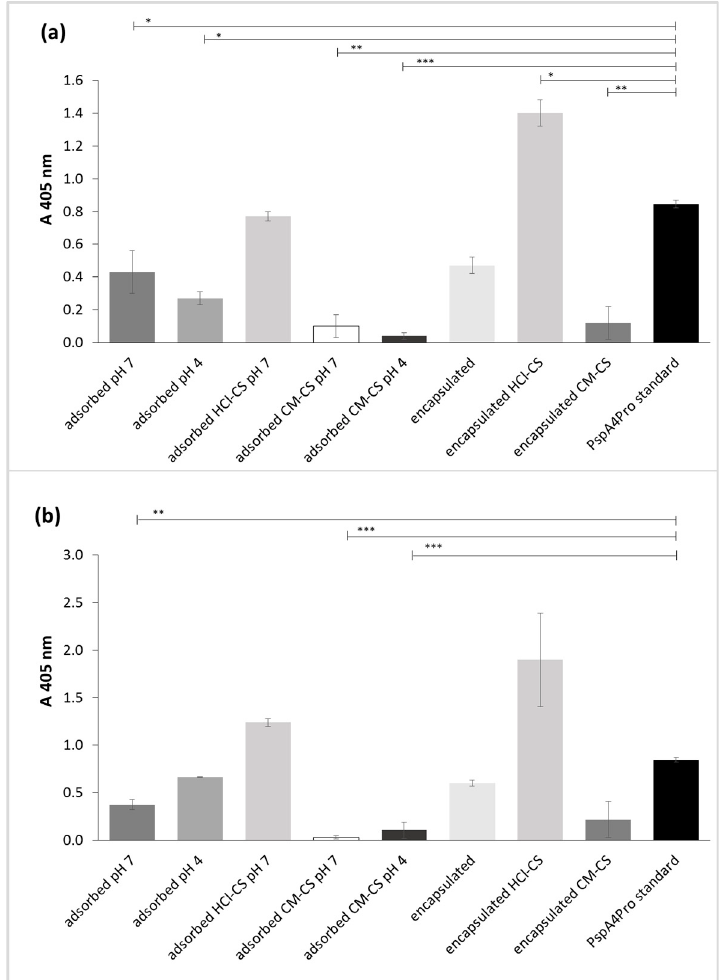
Figure 6. Lactoferrin binding assay of PspA4Pro released from NPs prepared with or without chitosan carrying surface-adsorbed PspA4Pro at pH 4.0 or 7.0 and NPs prepared at pH 7.0 by water-oil-water double emulsion with encapsulated PspA4Pro. ( a ) PGA-co-PDL NPs. ( b ) PLGA NPs. Chitosan hydrochloride (HCl-CS) or carboxymethyl chitosan (CM-CS) were employed. PspA4Pro standard was used as positive control. Data represent mean ± SD, n = 3. Statistical analysis: ANOVA/Tukey’s comparison test, * p < 0.05, ** p < 0.01, *** p < 0.001.